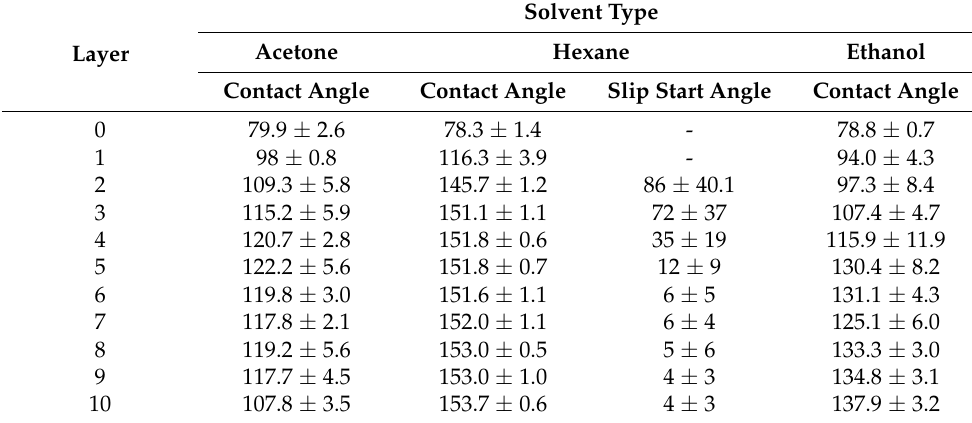
Table 2. Dependence of the characteristics of the coating on the solvent type. The slip start angle section is only shown for hexane because during the use of other solvents the drop did not slip. A dash means that the drop did not slip, even when the sample was turned upside